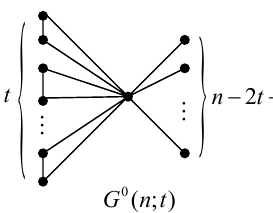
Figure 1. The graph G 0 ( n ; t )